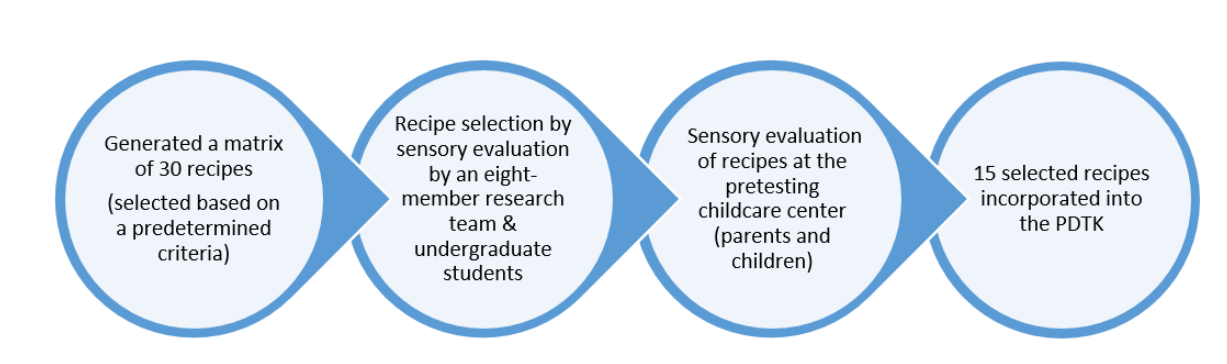
Figure 2. Step-by-step recipe selection process for integration into the Pulse Discovery Toolkit